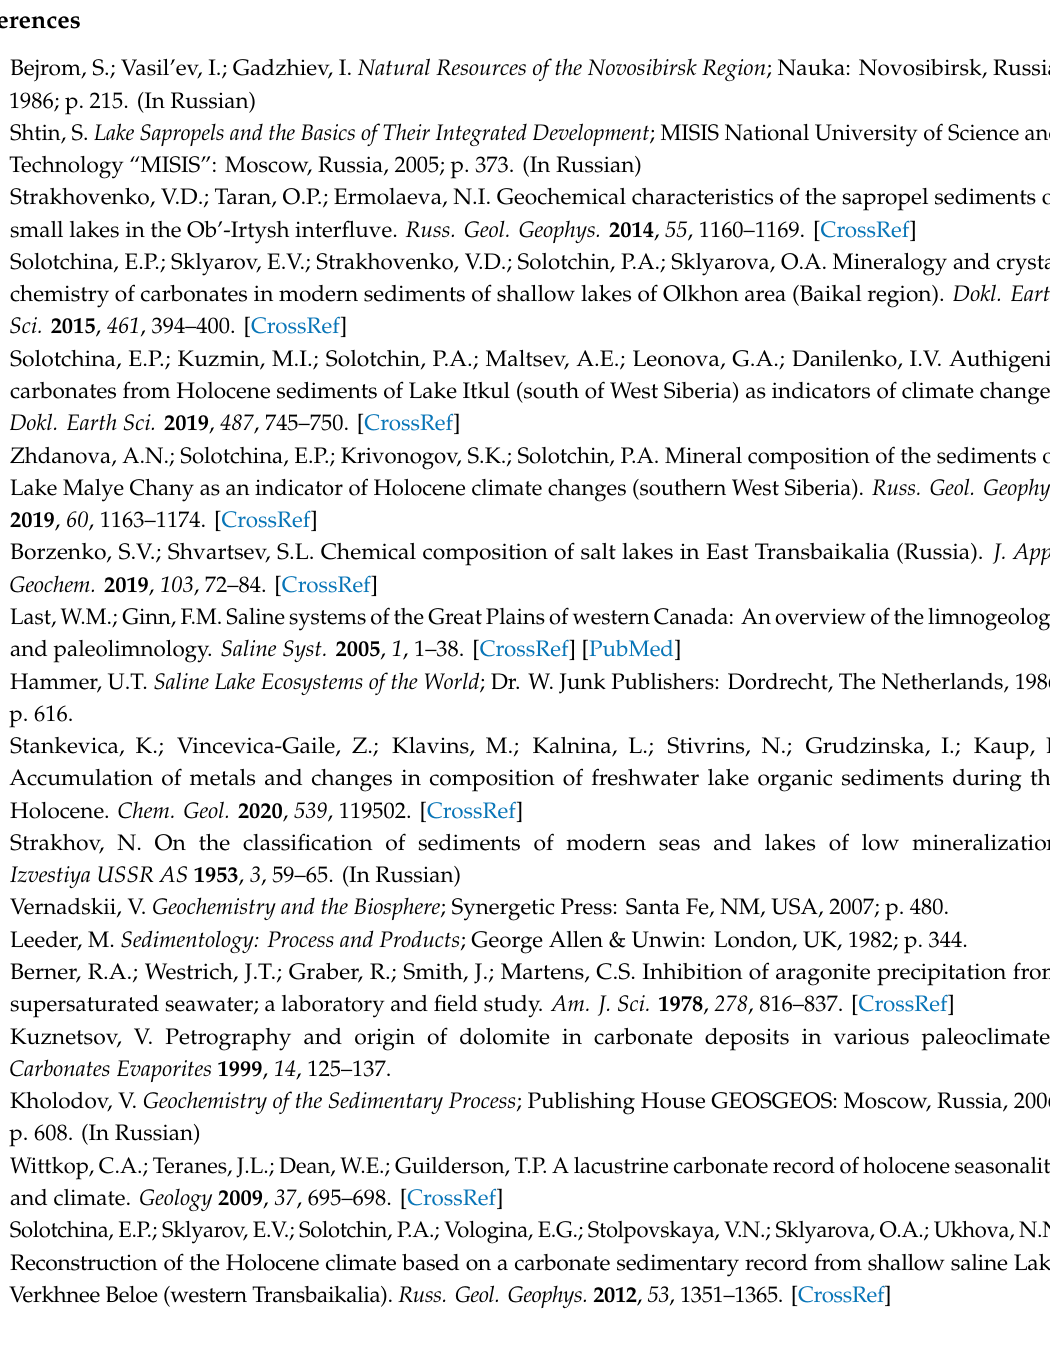
Table S1: Studied lakes (territories, landscapes, and lake